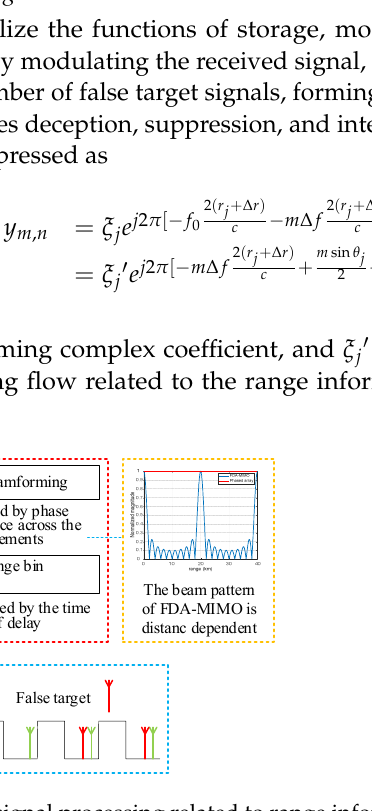
Figure 3. The flow of signal processing related to range information at the FDA-MIMO receiver.